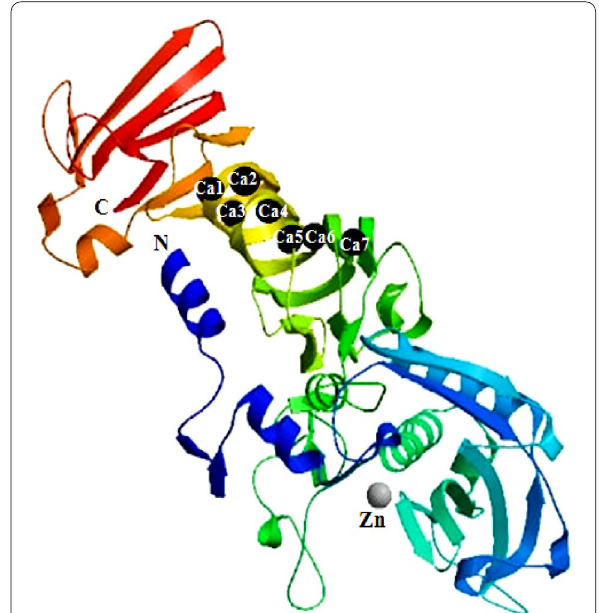
Fig. 7 Cartoon view of the overall three-dimensional structure of Serratiopeptidase, a ribbon diagram showing the positions of the secondary structure elements was built using online SWISS-MODEL software (https:// swiss model. expasy. org/) and colored according to secondary-structure element. β-Strands are depicted as arrows, the zinc ion is shown by a grey ball, and calcium ions by black balls